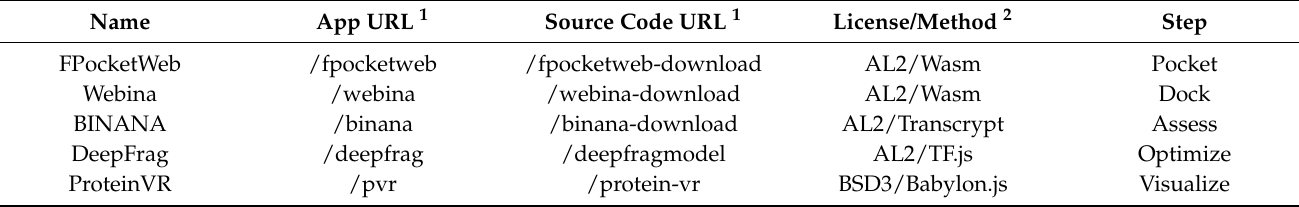
Table 1. Examples of CADD browser apps created in the Durrant